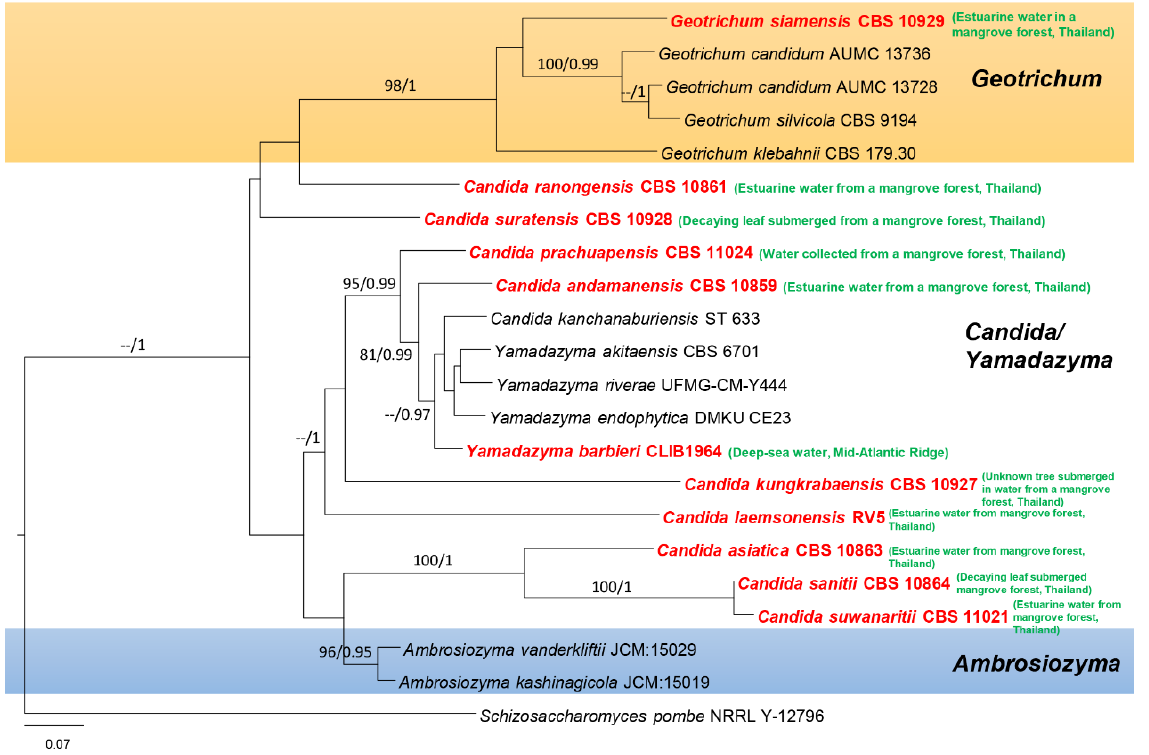
Figure 2. Maximum likelihood analysis with 1000 bootstrap replicates yielded the best tree with the likelihood value of − 8256.019037. The combined LSU and ITS sequence datasets were used for analysis with Schizosaccharomyces pombe (NRRL Y-12796) as the outgroup taxon. The matrix had 828 distinct alignment patterns, with 50.42% undetermined characters or gaps. The estimated base frequencies were A = 0.277031, C = 0.186671, G = 0.251694, and T = 0.284604; the substitution rates were AC = 0.632253, AG = 1.870647, AT = 1.340467, CG = 0.776808, CT = 4.053598, and GT = 1.000000; and the gamma distribution shape parameter was α = 0.771407. The maximum likelihood bootstrap (ML) values were ≥ 75% and the Bayesian posterior probabilities (PP) ≥ 0.95% are given above/below the nodes. The scale bar indicates 0.07 changes. The marine fungi isolates are shown in red and bold.